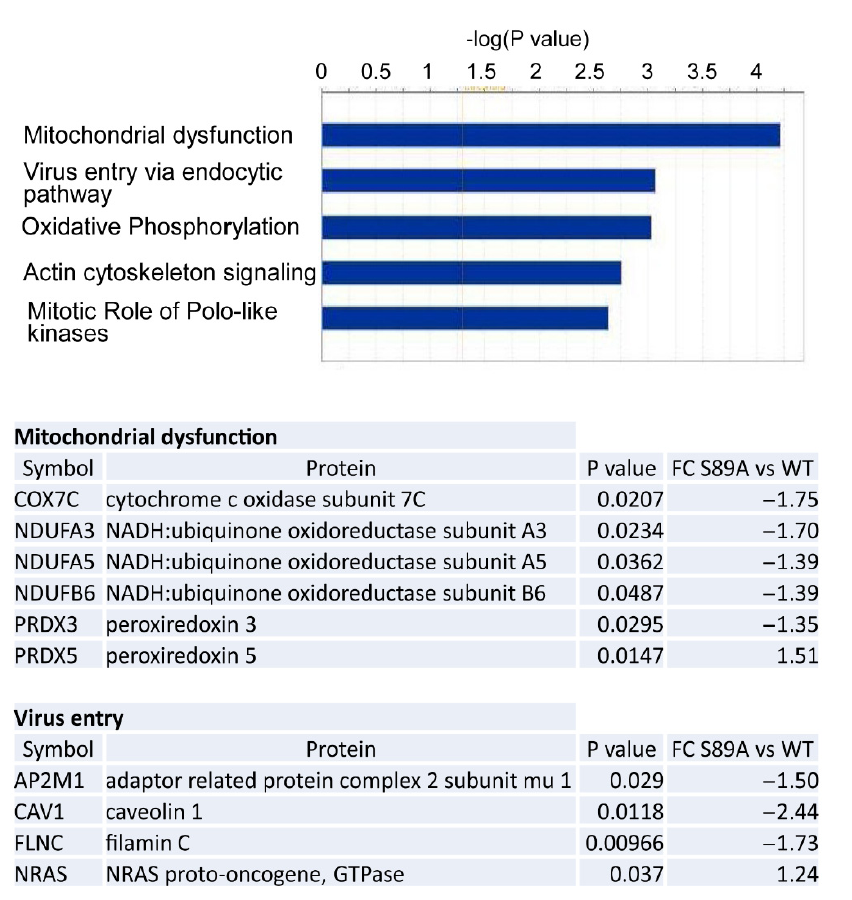
Figure 6. Bioinformatic analysis of proteins differentially expressed in p300 S89A mice intestinal tissue. IPA bioinformatic analysis of the 93 genes identified by proteomic analysis to be significantly differentially expressed in intestinal tissues of S89A versus WT mice (with fold change ≤ − 1.2 or fold change ≥ 1.2 and p < 0.05) revealed the Mitochondrial dysfunction and Virus entry via endocytic pathway as top canonical pathways associated with S89A mutation (top). Differentially expressed proteins comprising the Mitochondrial dysfunction and Virus entry via endocytic pathways and associated fold change (FC) in intestinal tissues of S89A versus WT mice (bottom). ( n = 3–4 per group.)